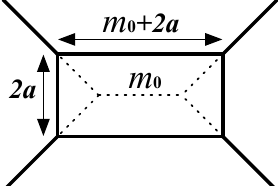
Figure 26 . Parametrization for the 5-brane web without O 5 -plane for the pure SU(2) gauge